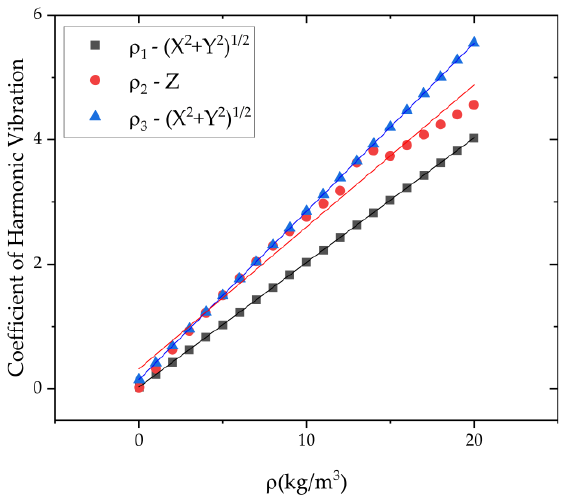
Figure 10. The coefficient of harmonic vibration under the first three harmonic errors ρ 1,2,3 .